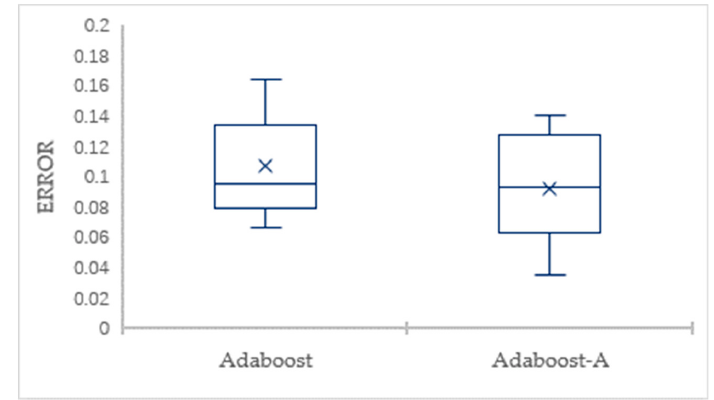
Figure 3. The Error Comparison of AdaBoost and AdaBoost-A on Vehicle Dataset.